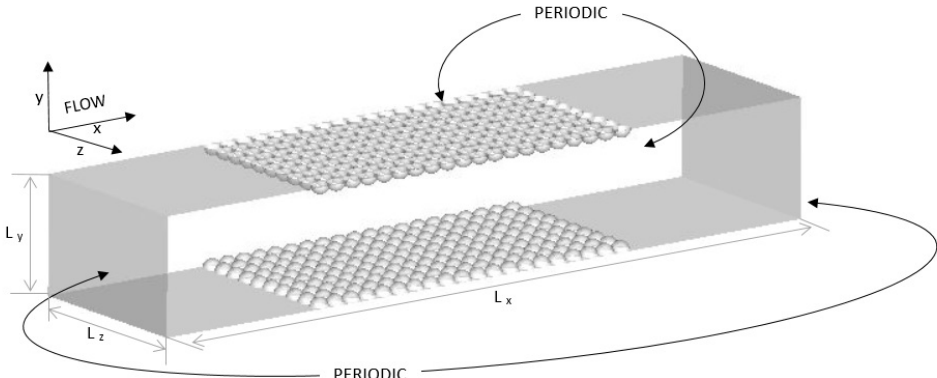
Figure 2. Schematic view of the computational domain with spherical elements embedded in the upper and lower